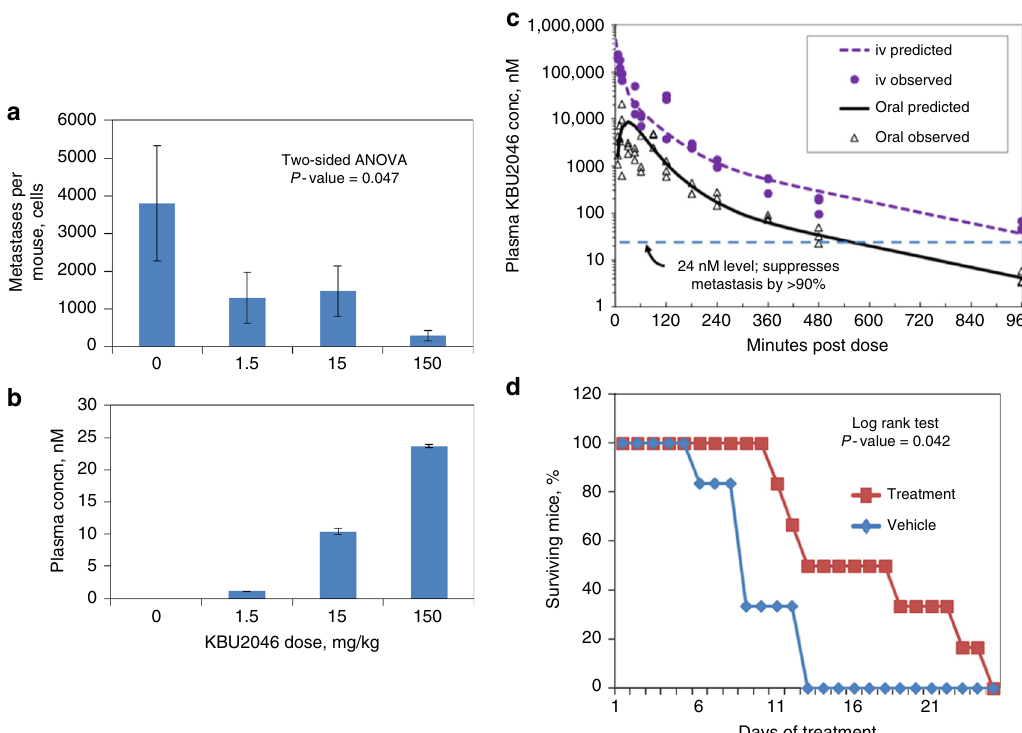
Fig. 2 KBU2046 inhibits cancer metastasis and prolongs life. a , b Inhibition of PCa metastasis. Cohorts of N = 12 athymic mice bearing human PCa PC3-M cell orthotopic implants ( a ), or of N = 5 non-tumor bearing athymic mice ( b ), were treated with KBU2046 incorporated into chow, and resultant lung metastasis ( a ) or plasma KBU2046 concentration ( b ) measured. Values are the mean ± SEM. The relationship between dose and metastasis was evaluated by two-sided ANOVA ( a ). c Comprehensive characterization of KBU2046 pharmacokinetics. CD1 mice were dosed with 100 mg KBU2046/kg via oral gavage or intravenous injection (iv), and blood collected at the indicated time points (data from mice dosed at 25 mg/kg are in Supplementary Fig. 6, and corroborate 100 mg/kg fi ndings). For each route and time point, N = 3 mice were sampled. Individual data points are the resultant plasma concentrations from individual mice, and are the mean of N = 2 measurements. The dotted horizontal line denotes a concentration of 24 nM, which was the concentration of KBU2046 measured in the blood of mice whose metastasis were suppressed by 92% ( a , b ). d Prolongation of survival in BCa-bearing mice. Mice were orthotopically implanted with human breast cancer LM2-4H2N cells, the resultant primary tumors resected, and adjuvant treatment begun with KBU2046 by daily oral gavage fi ve times per week. The survival of N = 6 mice receiving vehicle was compared to that of N = 6 mice receiving 25 mg/kg KBU2046